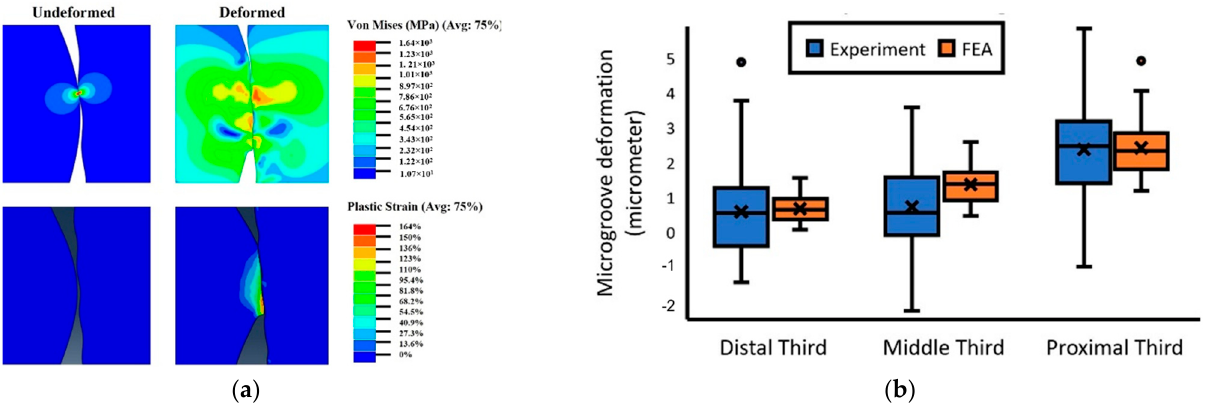
Figure 4. Plastic deformation observed in the microgrooves in Godoy et al. [32]: ( a ) the results of von Mises stress; ( b ) the deformation of the microgrooves in three regions along the trunnion length; circles represent the maximum values (upper extreme) of microgroove deformation.